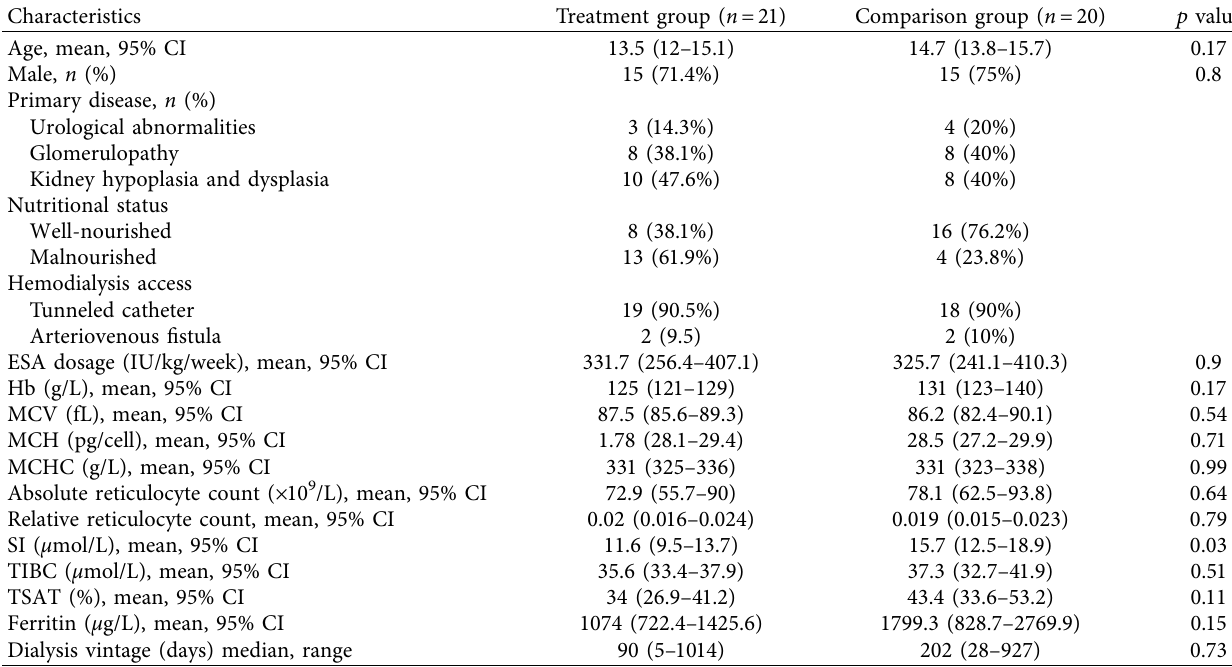
Table 1: Comparative baseline characteristics of the treatment group versus the comparison group.